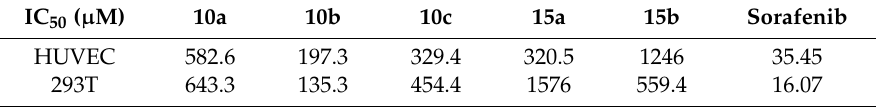
Table 2. Antiproliferation activities for 10a – c and 15a – b in nontumorigenesis cells.